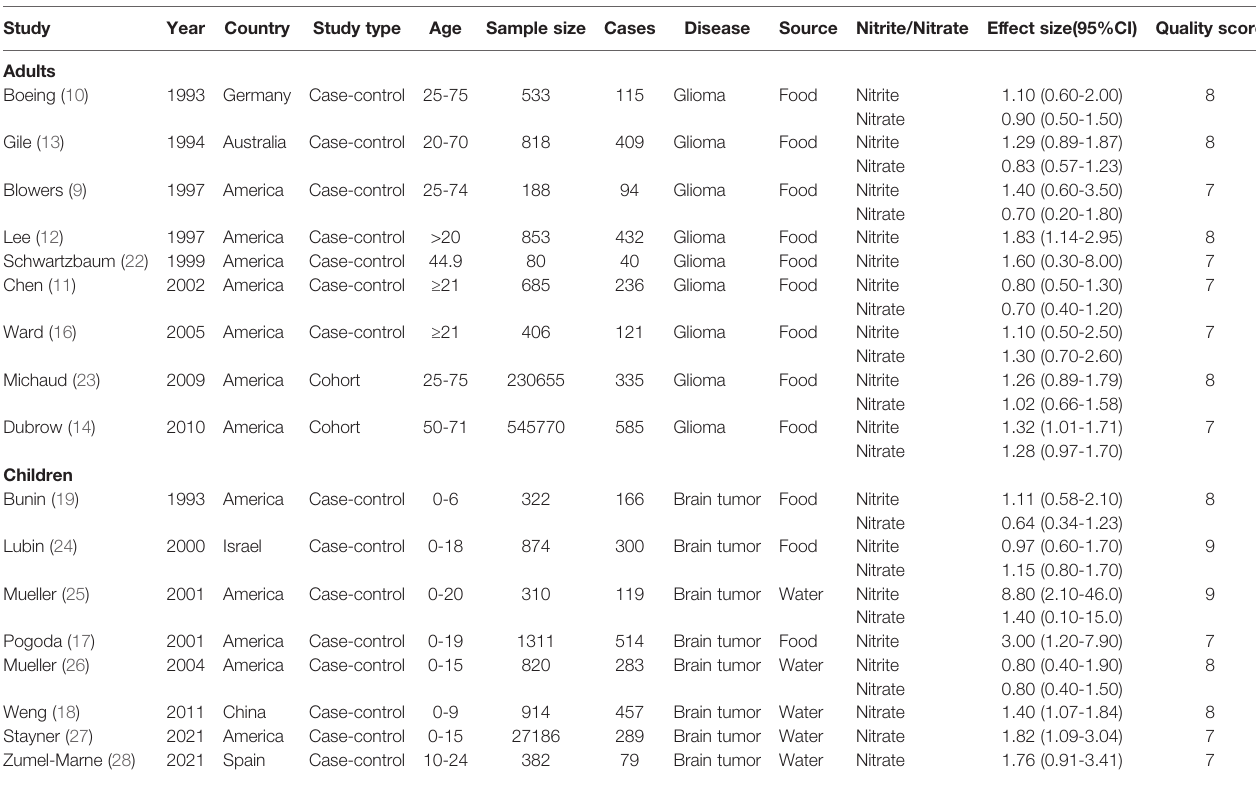
TABLE 1 | Characteristics of studies investigating the association between nitrite/nitrate and glioma.